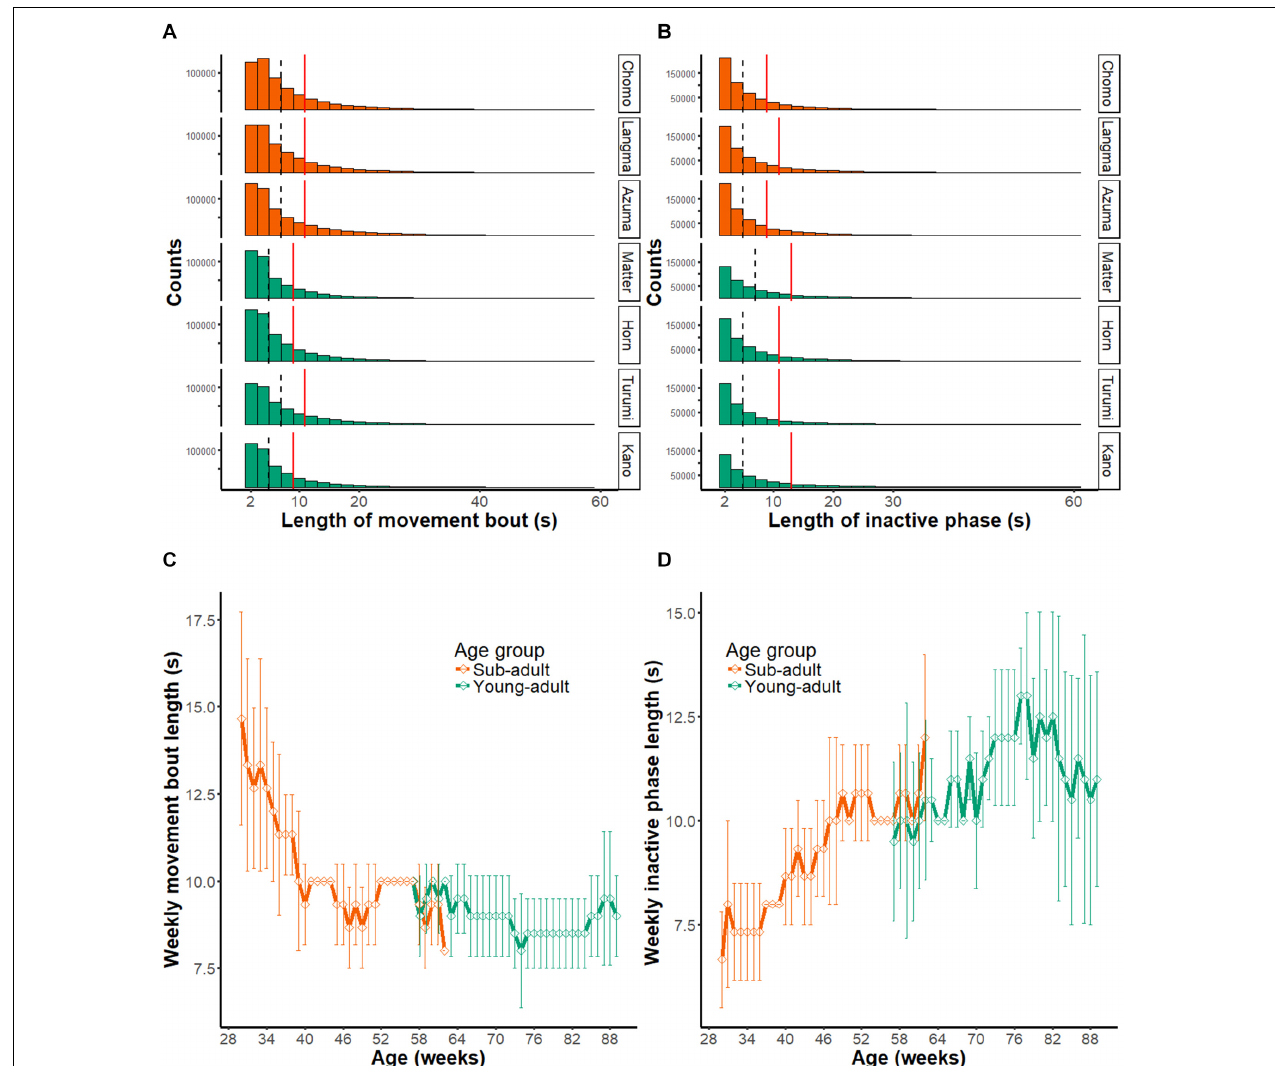
FIGURE 6 | Intermittent nature of marmoset activity. (A) Histograms showing the distribution of movement bout lengths during daytime at all periods of monitoring (231 days). The results of seven animals are presented separately. Note that bouts longer than 60 s (0.2% of all data) are not included in the histogram. Dashed line, median of all movement bouts; red solid line; third quantile point of all movement bouts. (B) Histograms showing the length of inactive phase during daytime at all periods of monitoring (231 days). Note that inactive phases longer than 60 s (2.6% of all data) are not included in the histogram. Dashed line, median of all movement bouts; red solid line, third quantile point of all movement bouts. (C) Longitudinal changes in the length of movement bout. Group mean ( ± SD) of the index is plotted as a function of mean age of animals. Note that the movement bout decreased as a function of age in the sub-adult group, but the young adult group did not show a significant change. (D) Length of the inactive phase is shown in the same format as in panel (C) . Note that the length of inactive phase continuously extended throughout the observed age